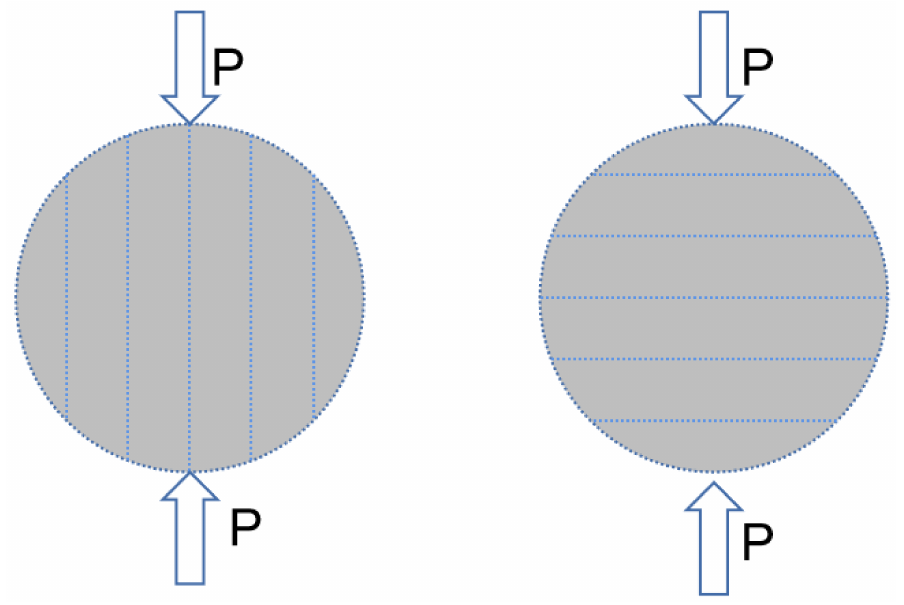
Figure 4. Loading modes of the